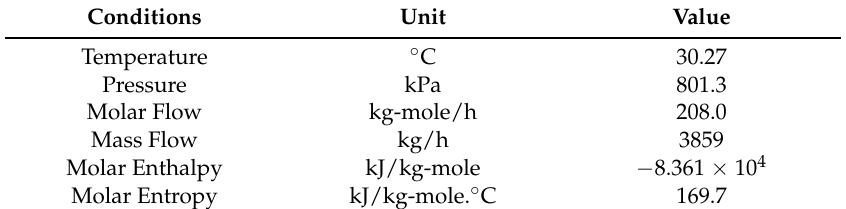
Table 2. Conditions of gathered flare gas [6].